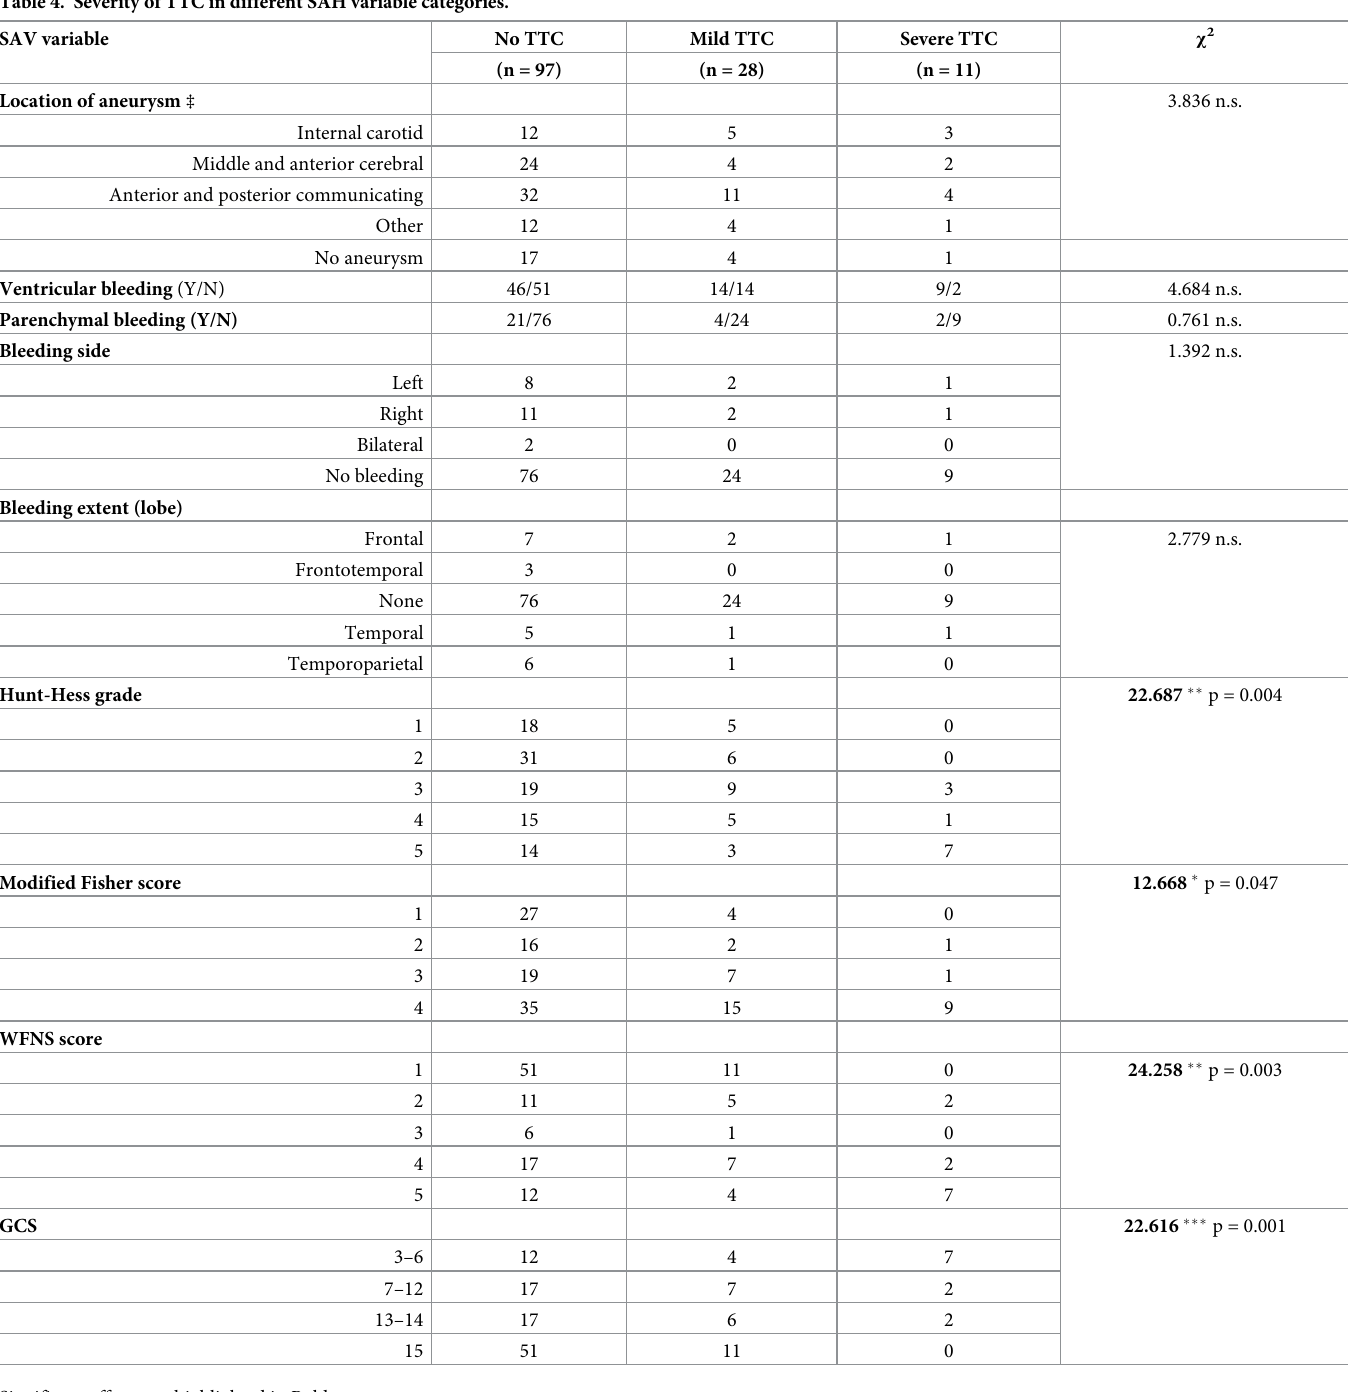
Table 4. Severity of TTC in different SAH variable